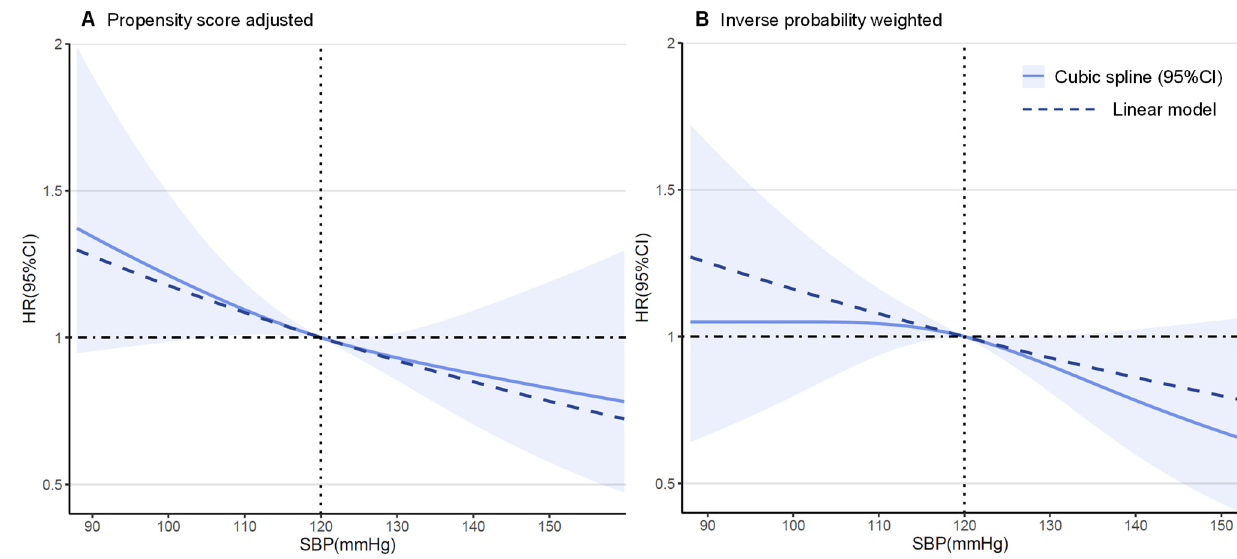
Figure 5. Restricted cubic spline plots for primary outcome by systolic blood pressure (SBP).